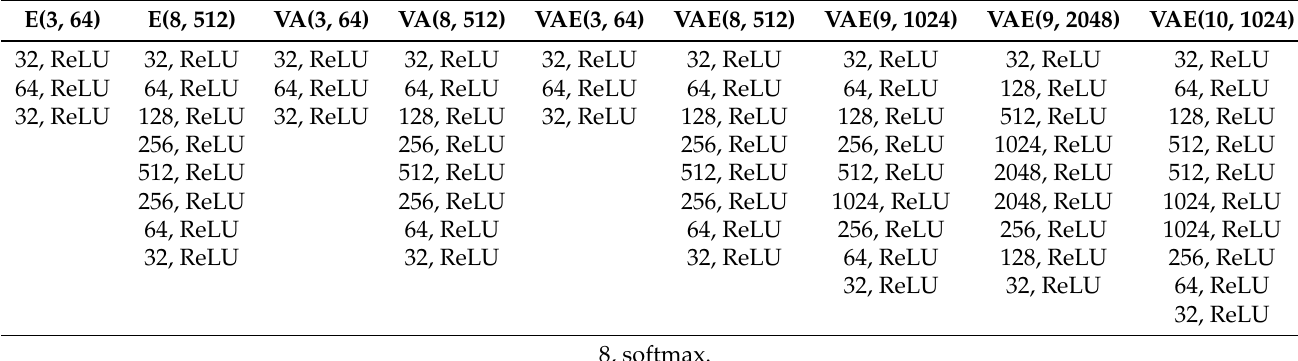
Table 3. Configurations of the proposed SFER